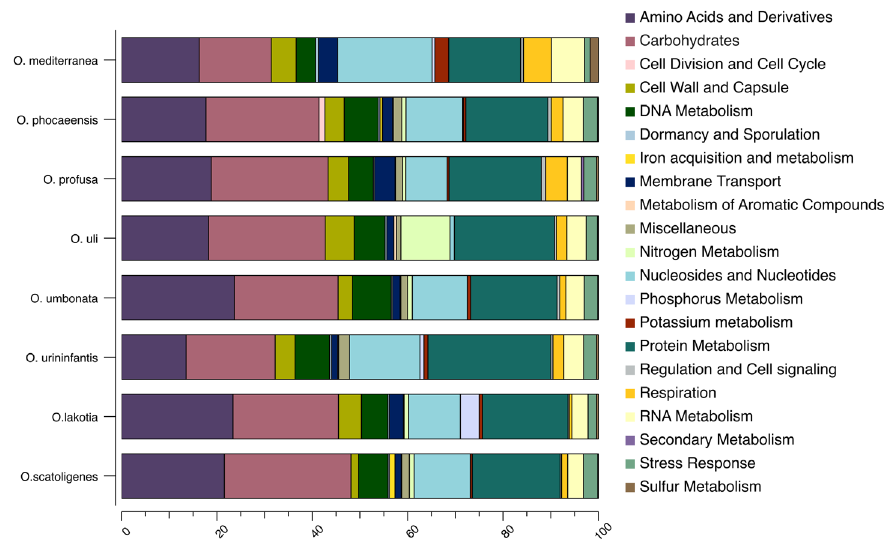
Figure 5. Distribution of functional features of predicted coding sequences of O. lakotia SW165 T and its neighbors. The functional features were predicted based on the clusters of orthologous groups. Heatmap was generated from the genome annotation of individual species by RAST using Explicet